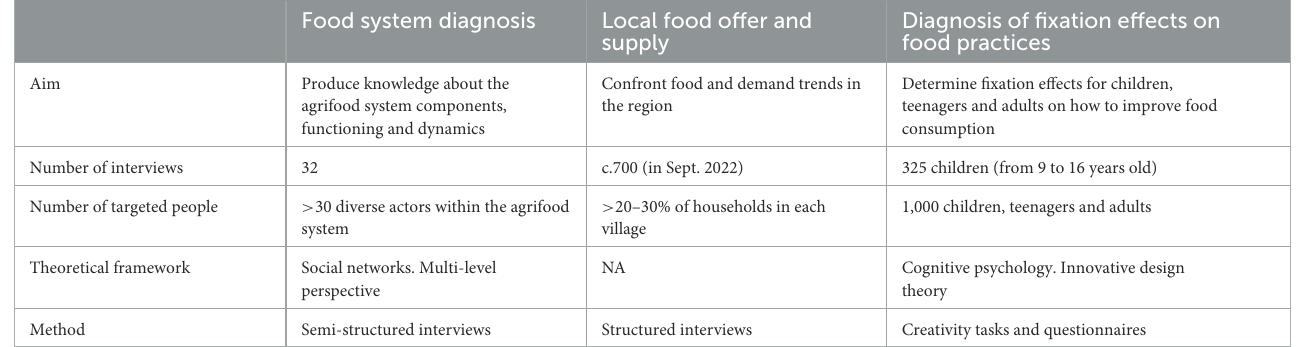
TABLE 2 Summary of the diagnosis and monitoring